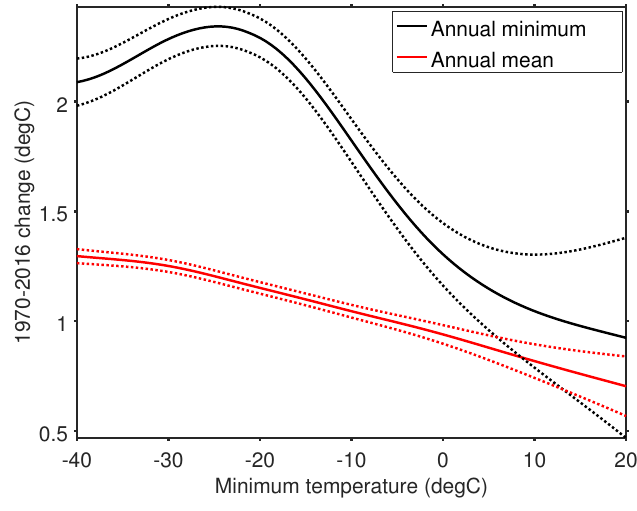
Figure 4. Mean increase in annual minimum temperature (black line) and in annual mean temperature (red line) over 1970–2016, as a function of climatological (1976–2005) annual minimum temperature. Dashed lines show 95% confidence intervals of the smoothed